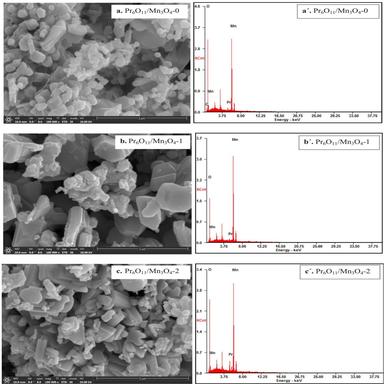
FE-SEM micrographs of Pr6O11/Mn3O4-0 (a), Pr6O11/Mn3O4-1 (b), Pr6O11/Mn3O4-2 (c) and EDX spectrum of Pr6O11/Mn3O4-0 (a´), Pr6O11/Mn3O4-1 (b´), Pr6O11/Mn3O4-2 (c´).